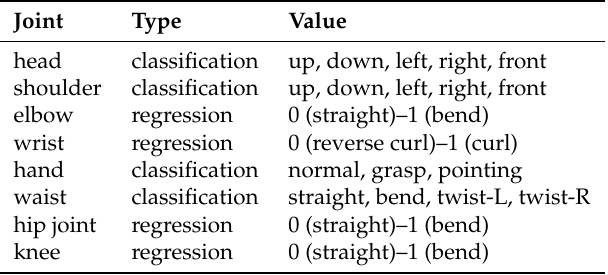
Table 2. The 14 body joints used as attributes and the types and values to represent their status. Note that each joint has left part and right part except head and